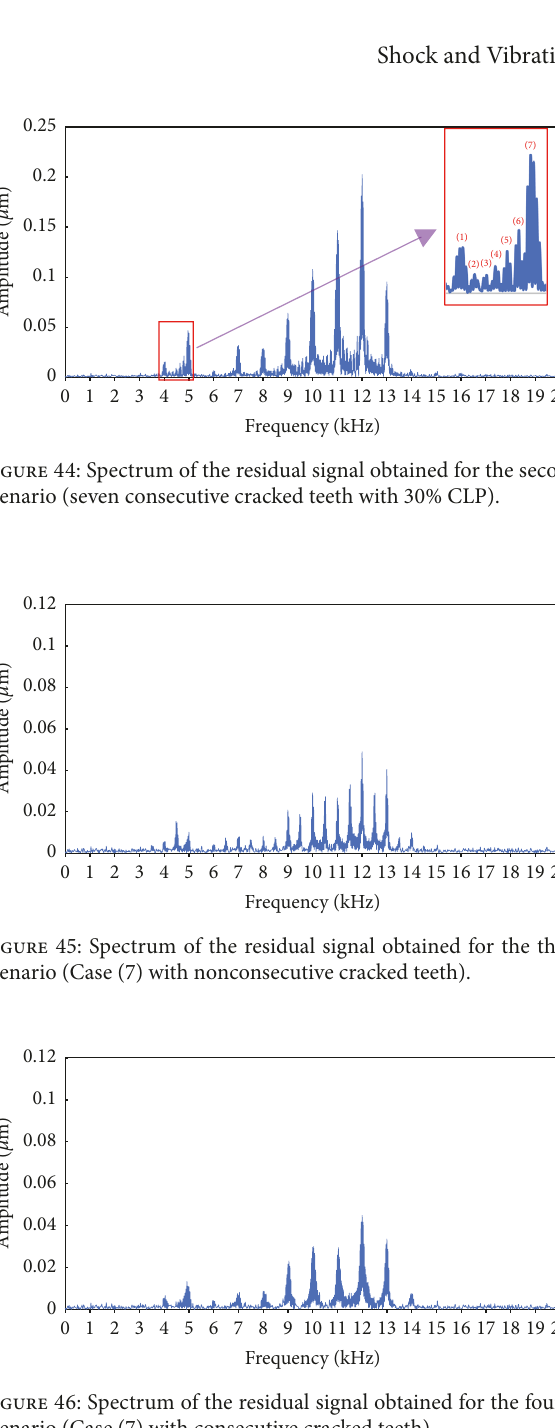
Figure 43: Percentage change in the peak of the residual signal spectrum for the first and second scenarios.